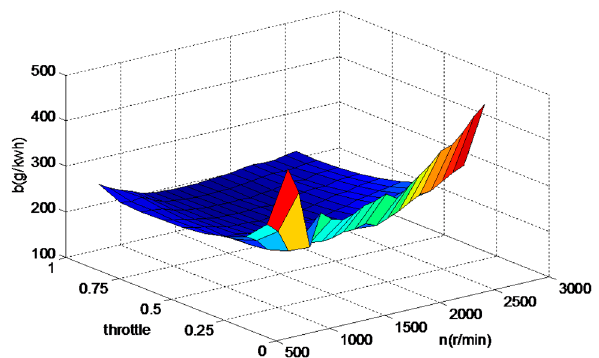
Figure 2. The engine fuel rate map.